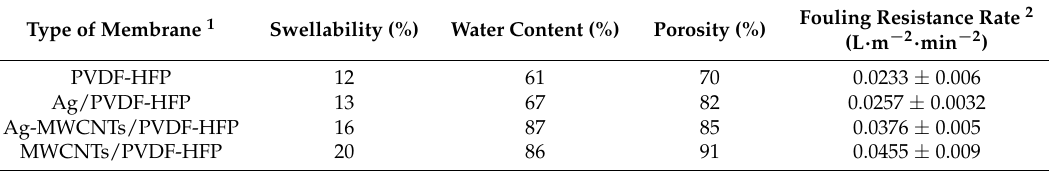
Table 1. Structural features and fouling resistance rate of PVD-HFP and composite membranes.